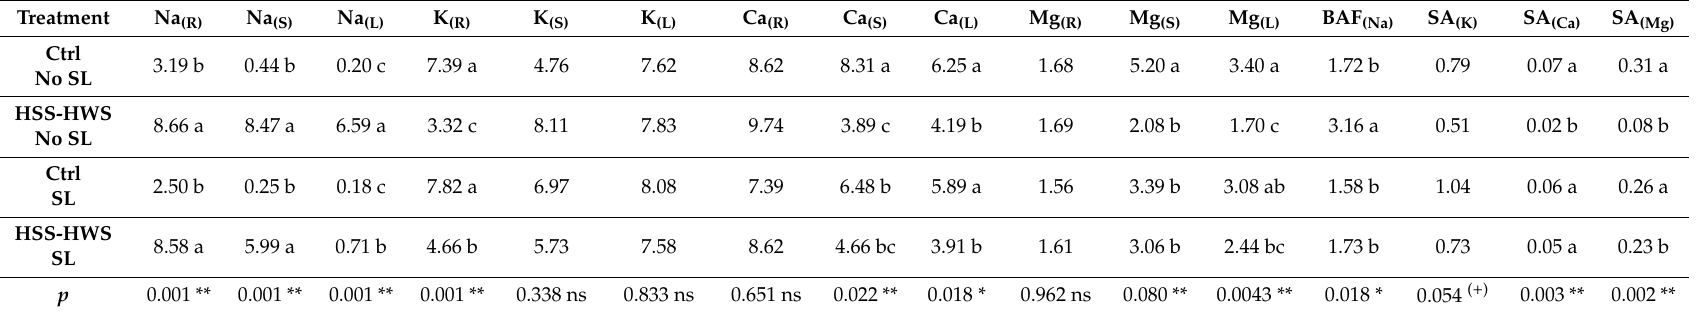
Table 3. Na, K, Ca, and Mg concentrations (mg kg − 1 DW) in roots (R), stem (S), and leaves (L); Na bioaccumulation factor (BAF); and K, Ca, and Mg